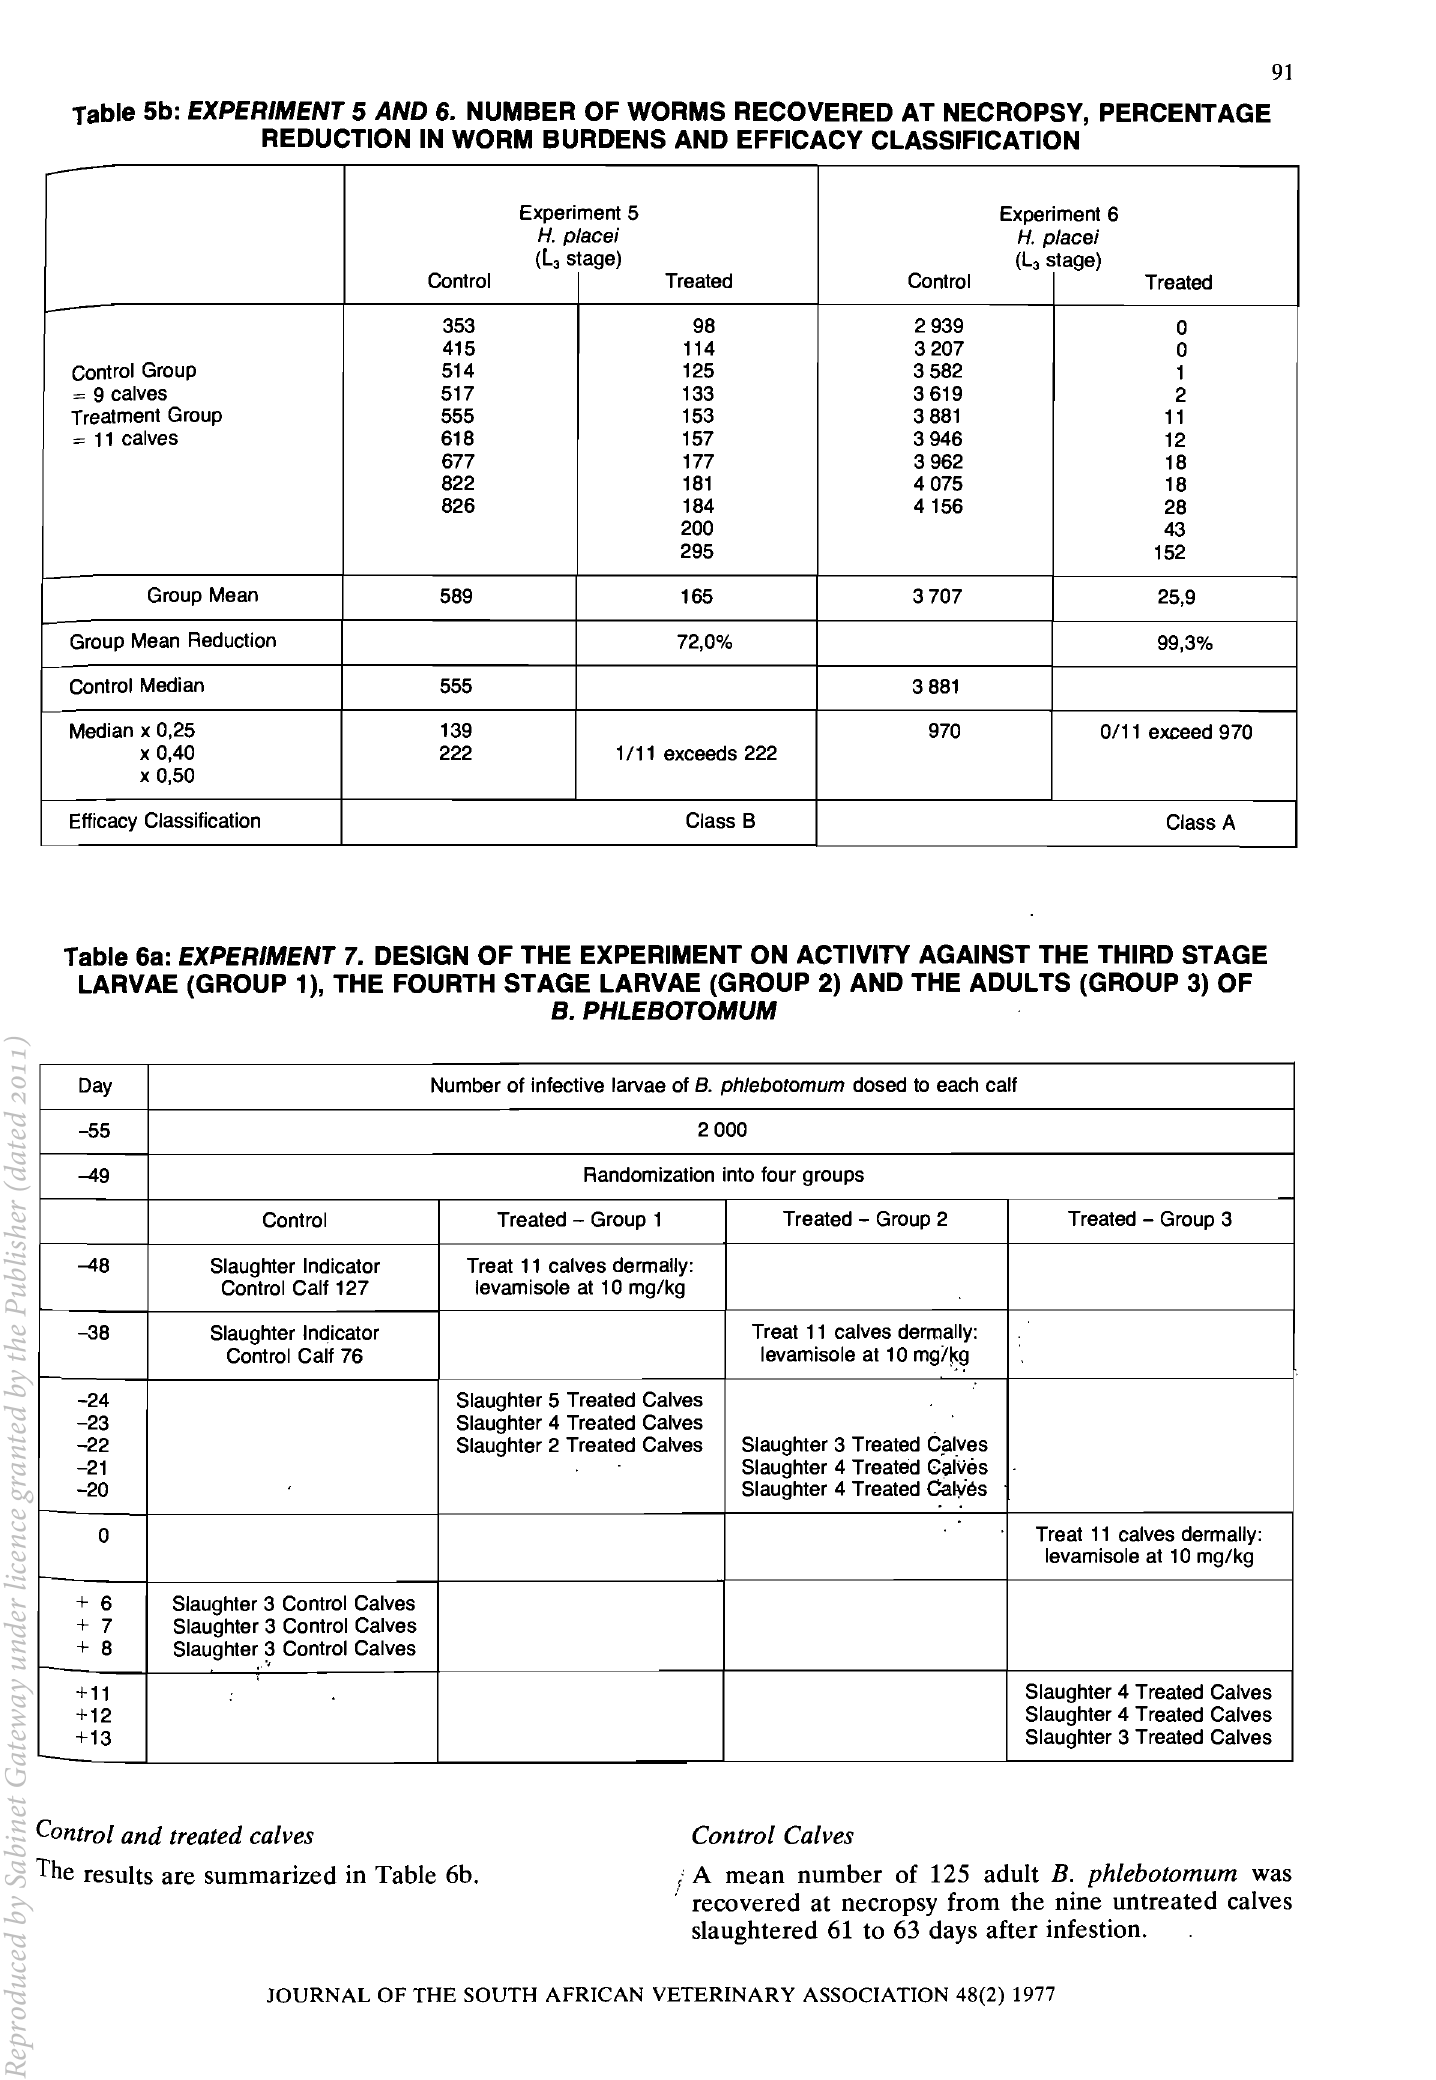
Table 5b: EXPERIMENT 5 AND 6. NUMBER OF WORMS RECOVERED AT NECROPSY, PERCENTAGE REDUCTION IN WORM BURDENS AND EFFICACY CLASSIFICATION